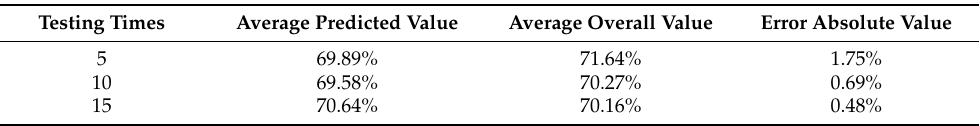
Figure 9. Analysis of correlation between conveyor operation speed and prediction accuracy. Table 1. Comparison of the number of spectral tests and the prediction accuracy of the average water content of fresh leaves.